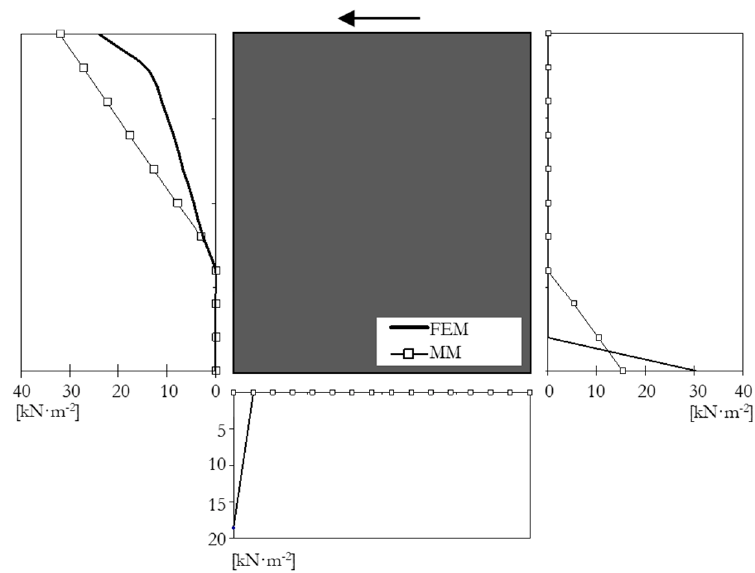
Figure 24. Pressure in the plane of symmetry, expressed in kN·m − 2 and determined by the Finite Element Model and the Matrix Model, on the walls and base of the footing due to a 2.61 kN shear load.